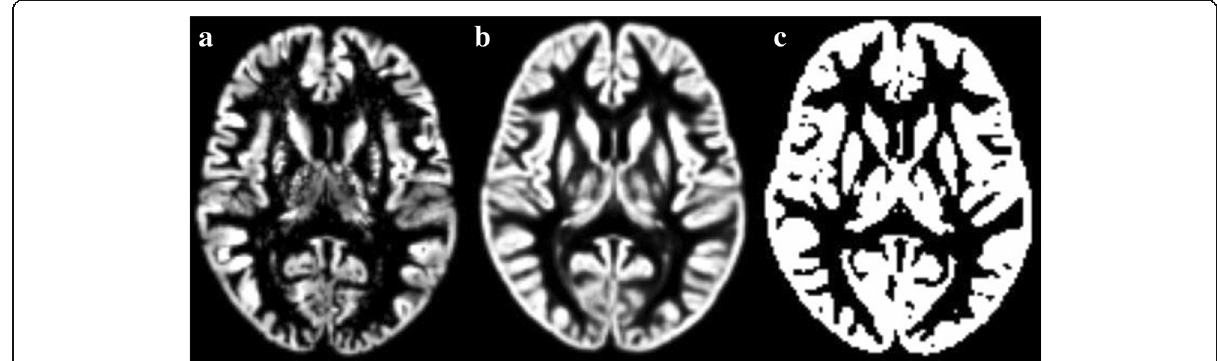
Fig. 2 The generation of customized gray matter mask. a , individual gray matter tissue probability maps; b , customized gray matter template; c , customized gray matter mask